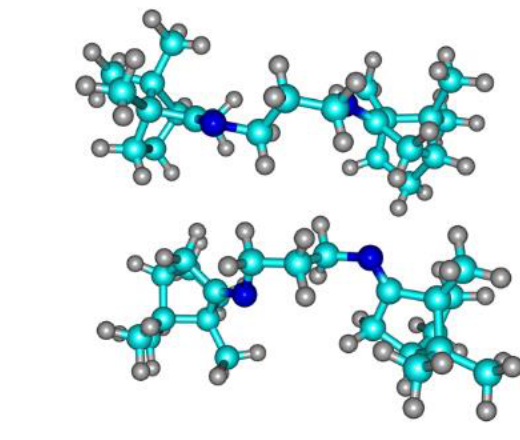
Figure 5. Fragment of the phase diagram of the CB-2+CPDA system ( a ) and dependence of HTP on the dopant concentration at 33 °C ( b ). The slope of the straight line β = d(T NI /T° NI )/dc (Figure 4a) was calculated, which is the degree of dopant effect on the thermal stability of the mesophase (Table 3). On the base of the quantitative analysis of the system of Newton’s rin gs by the Grandjean-Cano method (see the experimental section), the values of the helix pitch of chiral nematics were measured and the values of the helical twisting power (HTP) were calculated using the equation: HTP = (p · c · r) −1